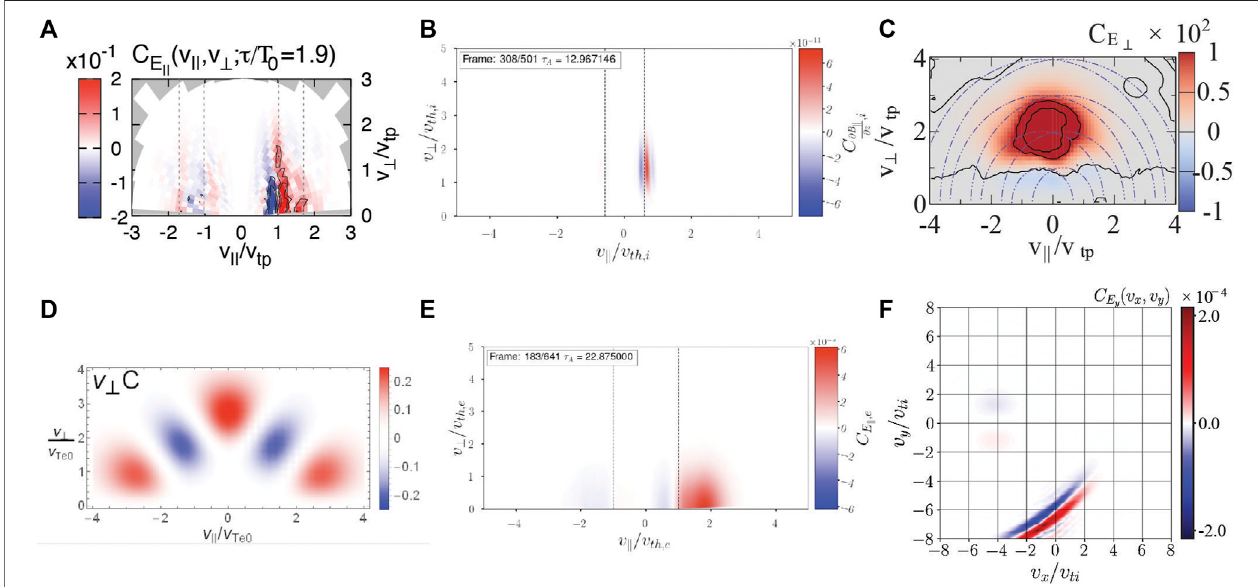
FIGURE 2 | Velocity-space signatures from the application of the fi eld-particle correlation technique to numerous kinetic particle energization mechanisms: (A) gyrotropicvelocity-spacesignaturefromthestandardparallel fi eld-particlecorrelation C E (cid:3) ( v (cid:3) , v ⊥ ) forionLandaudampinginagyrokineticsimulationofplasmaturbulence (Kleinetal.,2017); (B) parallel fi eld-particlecorrelationfortransit-timedampingbythemagneticmirrorforce C δ B (cid:3) ( v (cid:3) , v ⊥ ) foralinearkineticAlfvénwave; (C) perpendicular fi eld-particle correlation C ( v (cid:3) , v ⊥ ) for ion cyclotron damping from a hybrid Vlasov-Maxwell simulation ofhigh-frequency plasma turbulence (Klein et al., 2020); (D) E ⊥ total fi eld-particlecorrelation C E ( v (cid:3) , v ⊥ )forelectronheatingfromanumericalmodelofmagneticpumping(MontagandHowes,2022); (E) parallel fi eld-particlecorrelation C E (cid:3) ( v (cid:3) , v ⊥ ) for electron energization from a strong-guide fi eld reconnection simulation (McCubbin et al., 2022); and (F) velocity-space signature of shock-drift ( v , v ) from a Vlasov simulation of a perpendicular collisionless shock with Alfvén Mach number M acceleration C E x y y